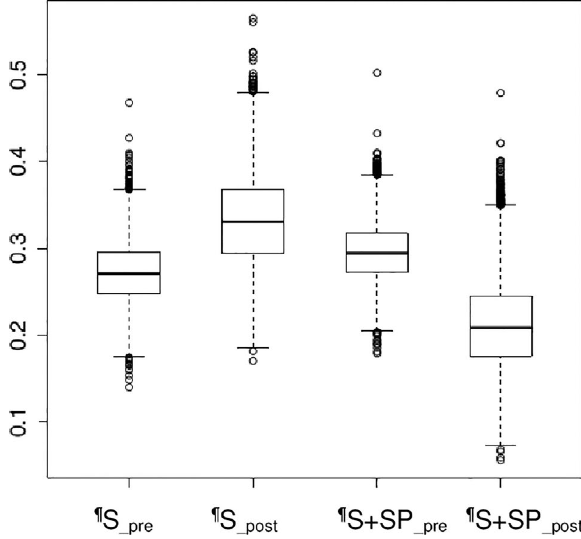
Figure 2 - Box plot of the posterior probability of volleyball perfect pass with displacement in the Skill (S) and Skill and strength/power (S+SP) groups in the pre- and post-training assessments